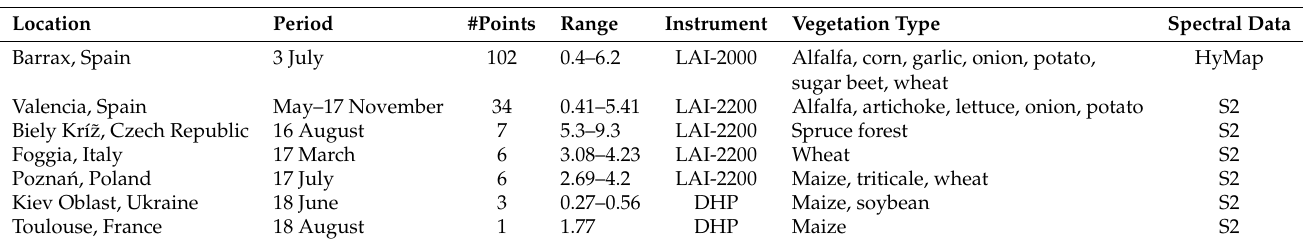
Table 1. Overview of field campaigns for leaf area index (LAI G ) collection used for training the Gaussian process regression (GPR) retrieval